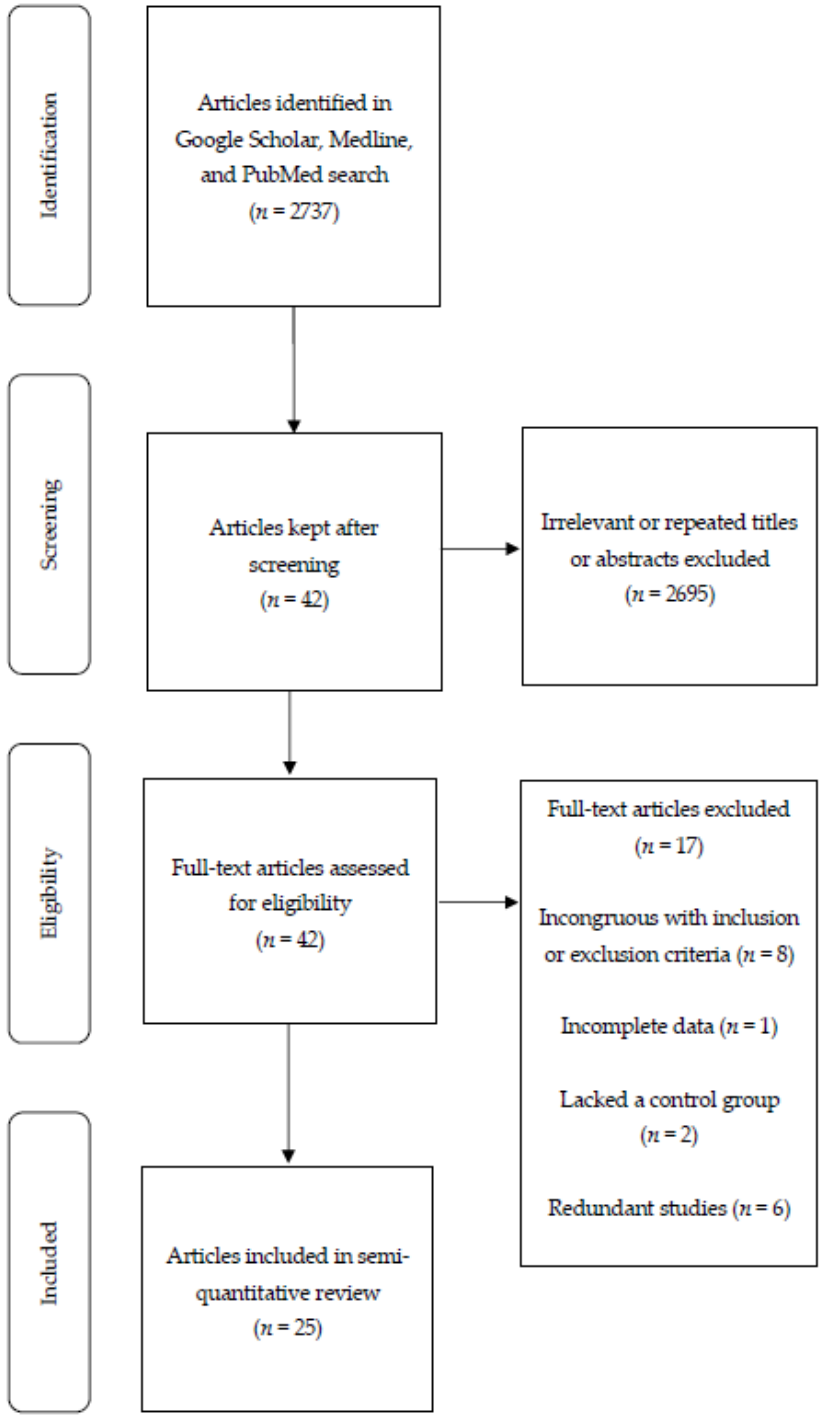
Figure 1. Flow diagram depicting the search and selection of published articles using our inclusion and exclusion